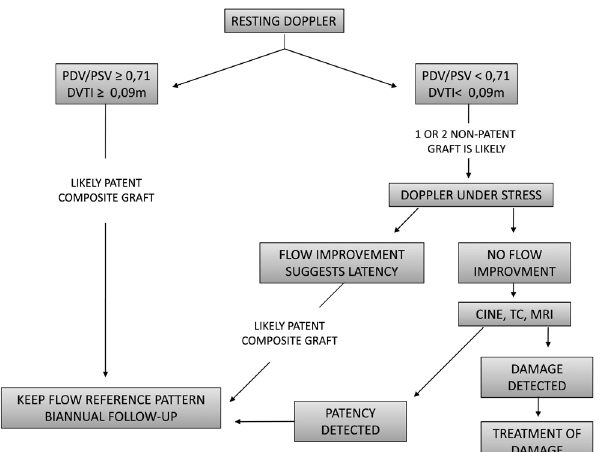
Fig. 3 – Follow-up algorithm for bypass patients with composite LITA grafts that are grafted to the LAD and another LCS branch (1100% specificity for both, 39.86% sensitivity for DPV/SPV, 36.49% sensitivity for DVTI, 100% PPV for both, 11% NPV for DPV/SPV, and 10.48% NPV for